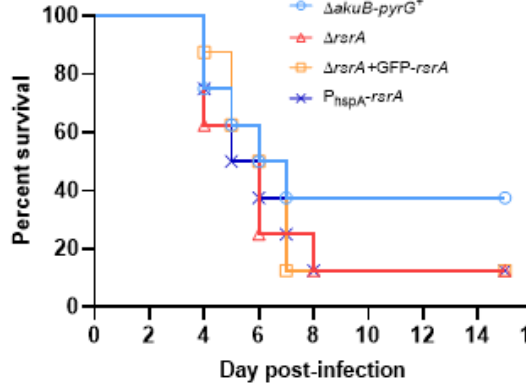
Figure 5. RsrA is not essential for the virulence of A. fumigatus . Survival curves of mice ( n = 8) infected intranasally with 10 6 conidia of control and rsrA mutant strains. The Kaplan–Meier curves were compared using log rank tests in GraphPad Prism v. 8.2.1. No statistical di ff erences were observed between experimental arms.